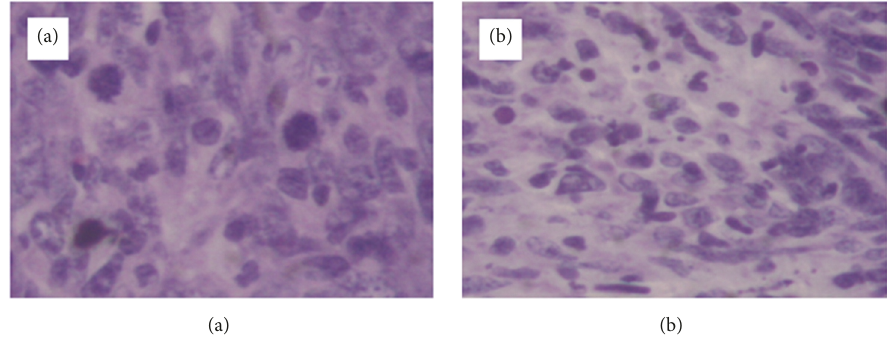
Figure 16: Microscopic finding of squamous cell carcinoma (1cm x 1cm) occurring on the right upper thigh after inoculation of SCC-7 in 10mA × 600sec group. (a) Tissue section taken 6 hours after treatment. There is focal cellular apoptotic body of SCC (H & E, x400). (b) Tissue section taken 24 hours after treatment. There is destructive change including moderately fragmented and necrotic neoplastic cells (H & E, x400).